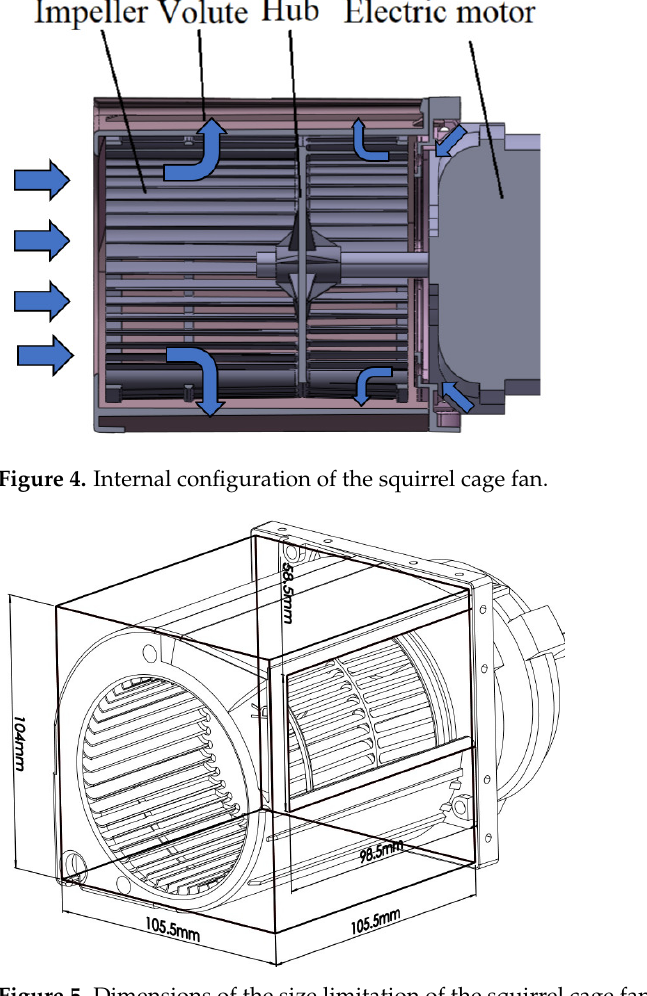
Figure 5. Dimensions of the size limitation of the squirrel cage